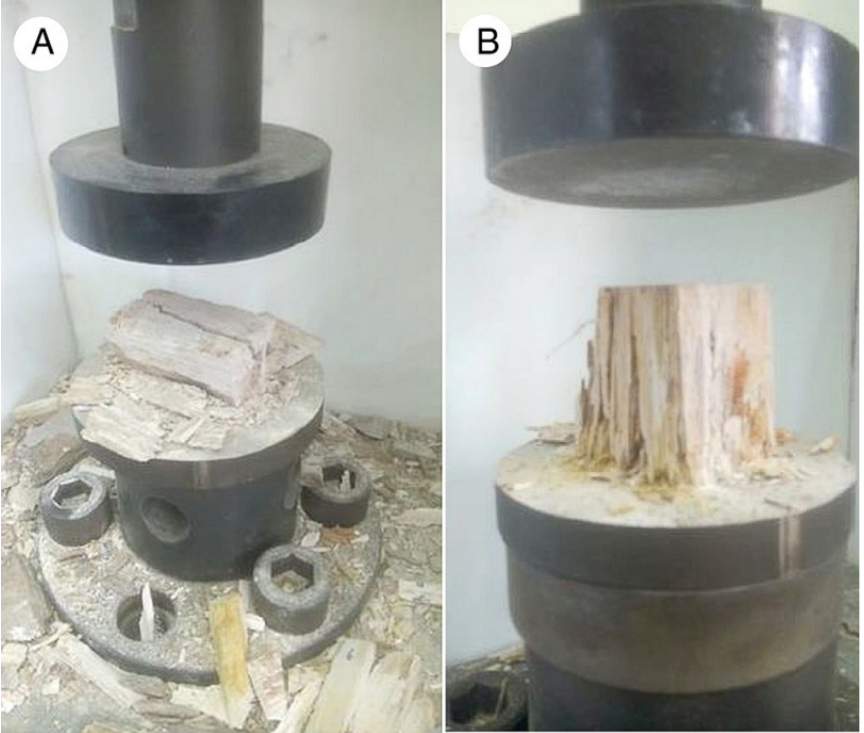
Figure 21. Testing compression strength. ( A ) longitudinal orientation. ( B ) transverse orientation.